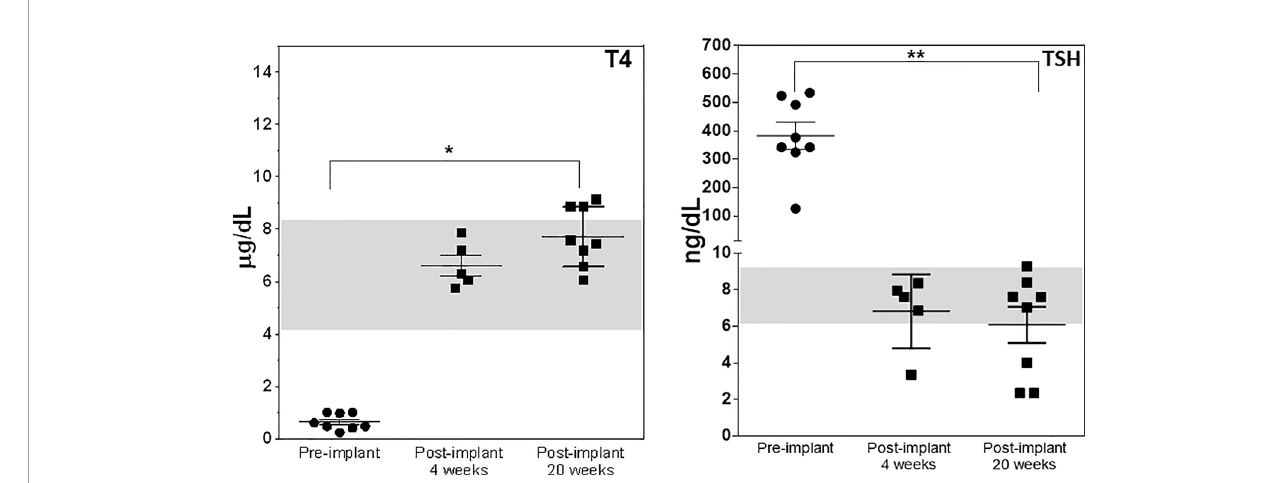
FIGURE 8 | Thyroid function post transplantation. Total T4 (left panel) and TSH (right panel) were measured in the serum of mice implanted with cells under the kidney capsule at 4 and 20 weeks and in the muscle and eye at just 20 weeks using the multiplex bead assay as described in Materials and Method. Signi fi cant